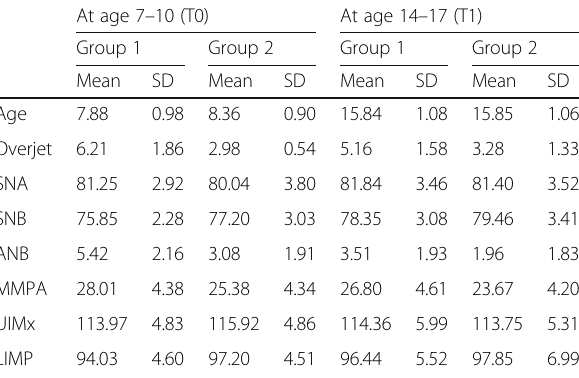
Table 1 Assessment of the repeatability of measures in the Table 3 Clinical and cephalometric descriptive results per